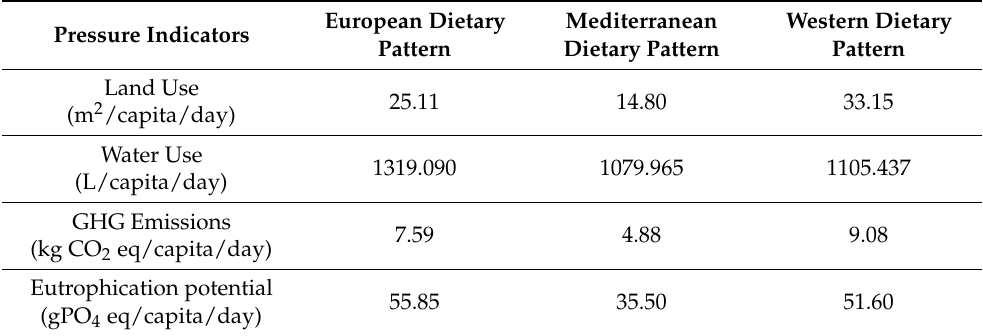
Table 2. Environmental footprints for the Mediterranean dietary pattern, European dietary pattern, and Western dietary